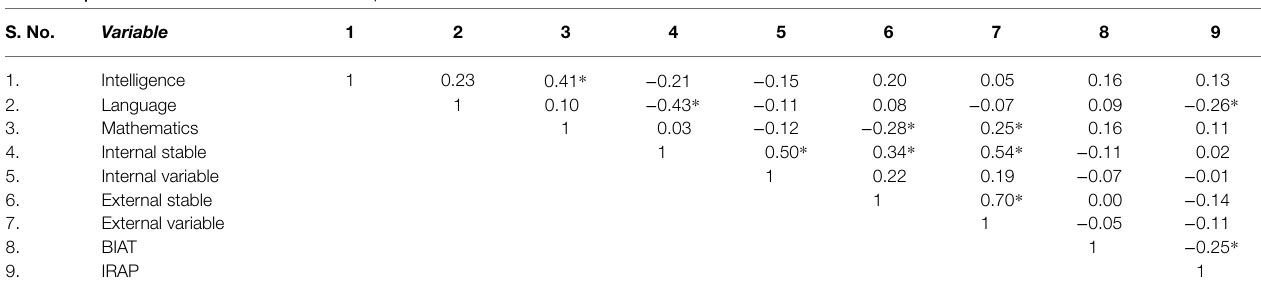
TABLE 2 | Correlations between the different dependent variables. S.